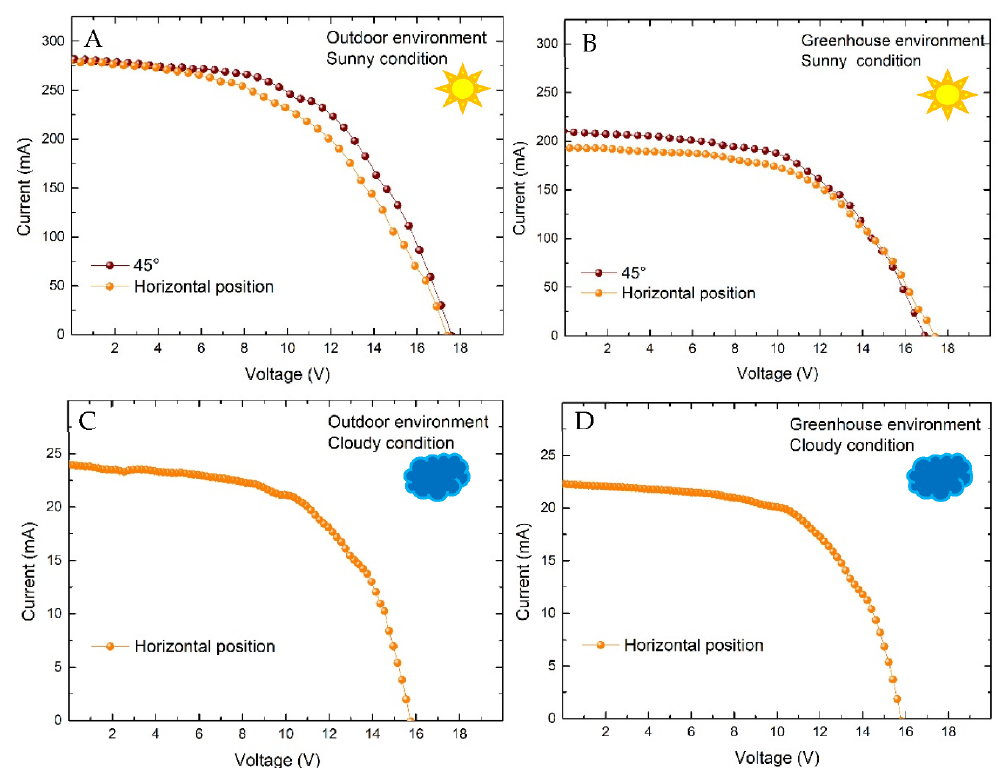
Figure 12. ( A ): IV in sunny and clear conditions, outdoor environment. ( B ): IV in sunny and clear conditions, greenhouse environment. ( C ): IV cloudy conditions, outdoor environment. ( D ): IV cloudy conditions, greenhouse environment. Table 3. Electrical parameters of the DSSC panel at different meteorological conditions and envi- ronments. Panel’s active area: 886 cm 2 .